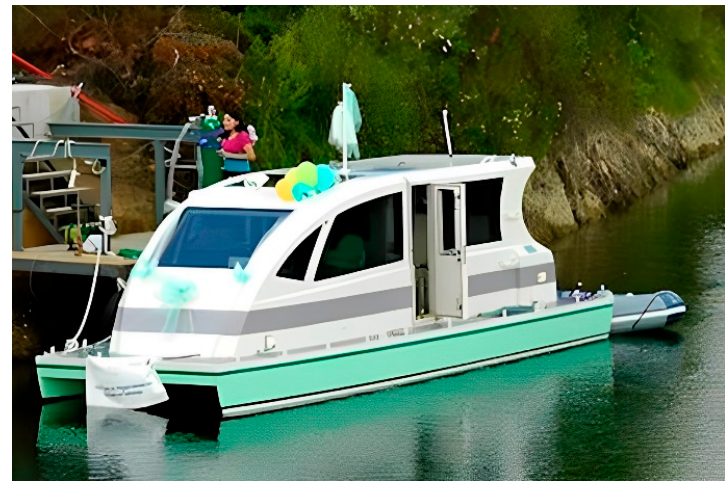
Figure 43. The Turkish fuel cell ship “Marti” [198].